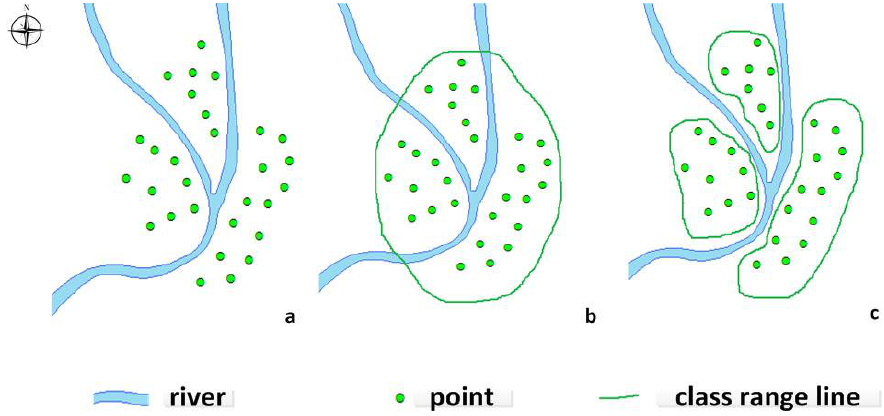
Figure 3. Constraints imposed by rivers. ( a ) The environment of clustering is subject to two rivers constraint. ( b ) Clustering without the rivers constraint. ( c ) Clustering with the rivers constraint.